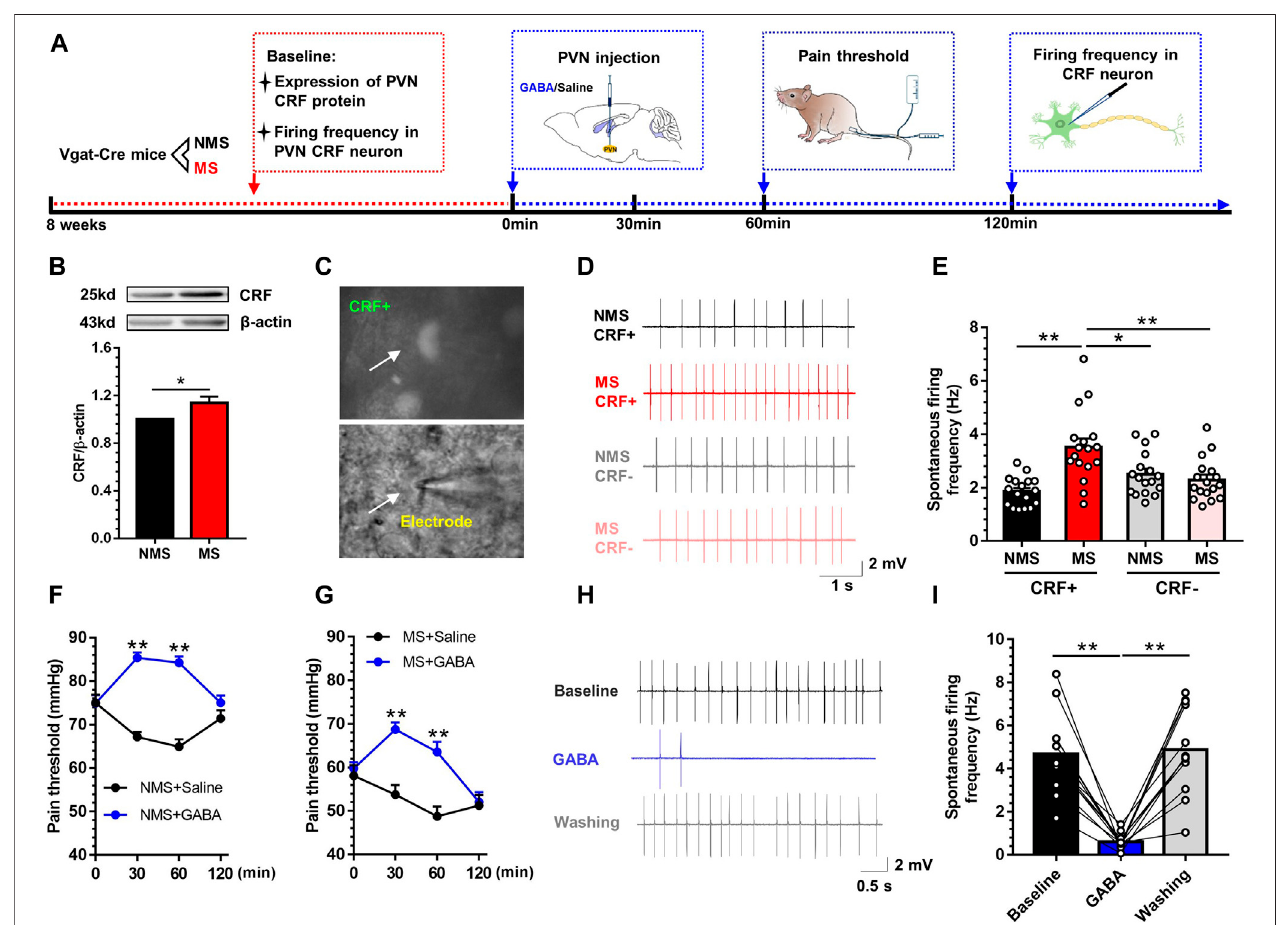
FIGURE 2 | MS induced the activation of CRF neurons in PVN, while microinjection of exogenous GABA into PVN could alleviate the visceral pain (A) The experiment fl owandtimelinefortheactivityofPVNCRFneurons (B) WesternblotshowedthattheexpressionofCRFproteinwassigni fi cantlyincreasedinMSgroupvs. NMSgroup( n (cid:2) 6) (C) Thediagramofspeci fi cCRF-neurons (D) Schemaofthetypical fi ringfrequency (E) Thespontaneous fi ringfrequencyofCRFneuronsinMSgroup was signi fi cantly increased vs. NMS group ( n (cid:2) 17, six mice per group) (F) Injection of exogenous GABA in PVN increased the visceral pain threshold in NMS mice vs. saline group ( n (cid:2) 8) (G) Injection of exogenous GABA in PVN increased the visceral pain threshold in MS mice vs. saline group ( n (cid:2) 8) (H) Schema of the typical fi ring frequency (I) Perfusion of exogenous GABA throughout brain slices could decrease the CRF neurons fi ring frequency in PVN of mice vs. baseline and post-perfusion pro fi les ( n (cid:2) 12, six mice per group). Data are presented as the mean ± S.E.M. * p < 0.05, ** p < 0.01 vs. indicated group.